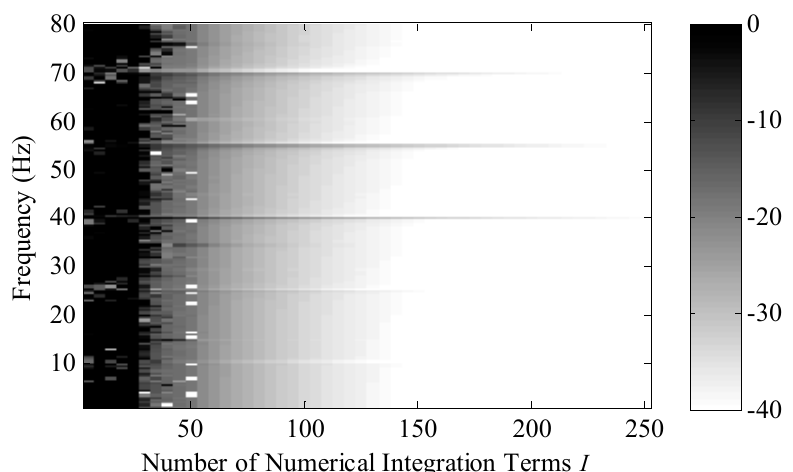
Figure 9. Convergence of the longitudinal displacement versus total number of integration terms and